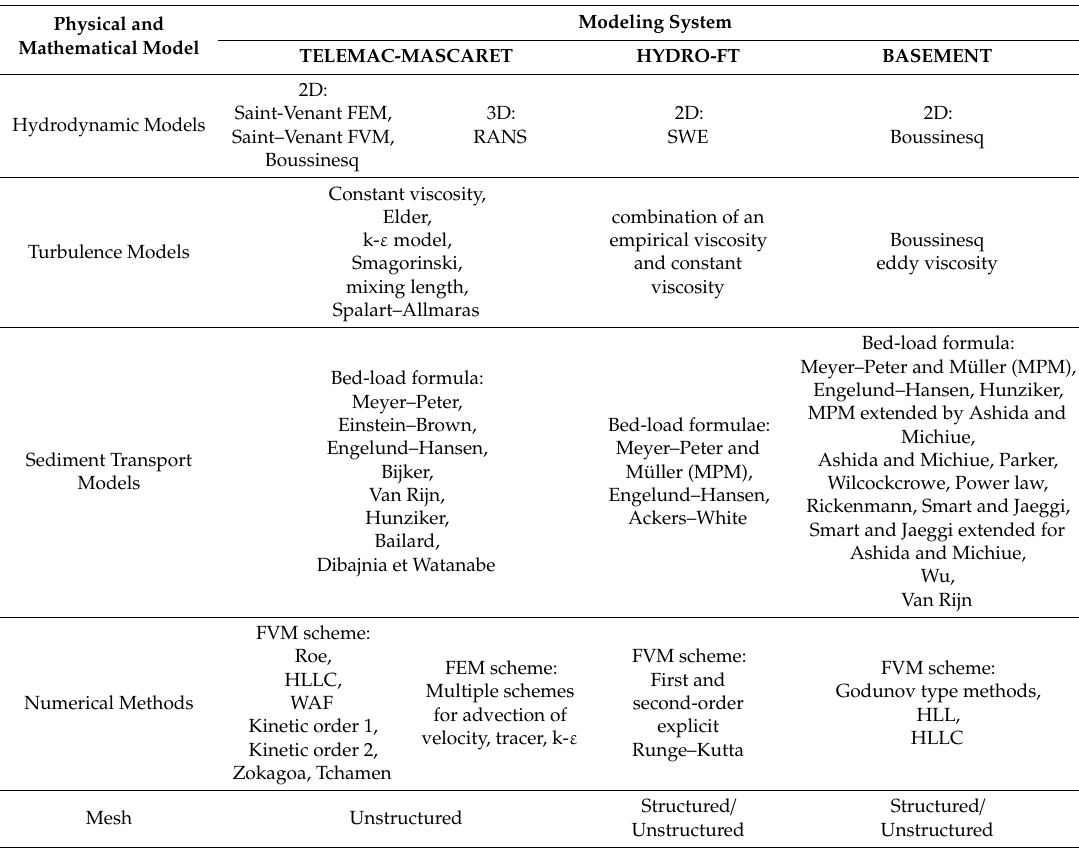
Table 1. Background information on physical and mathematical theories, as well as numerical methods applied in each modeling system.